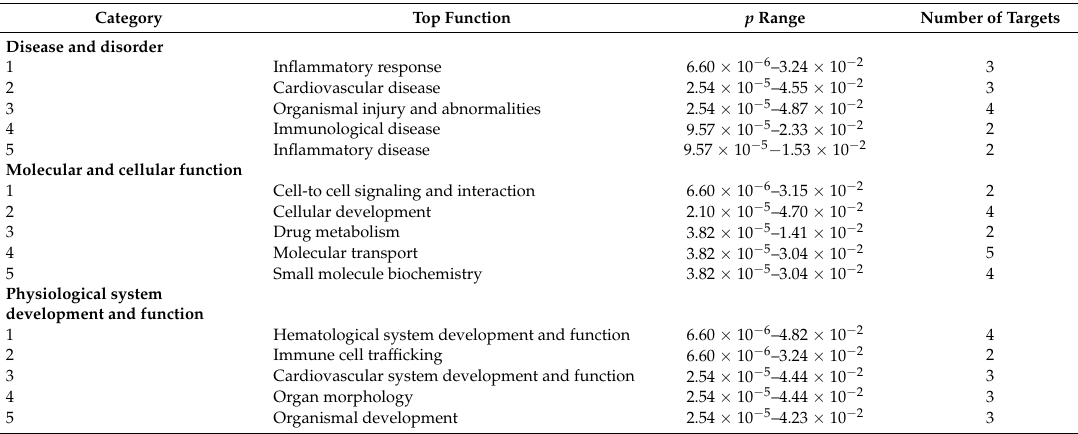
Table 6. Biological function associated with GDM/ SIRT1 ( ↑ ) identified based on Ingenuity Pathway Analysis (IPA).